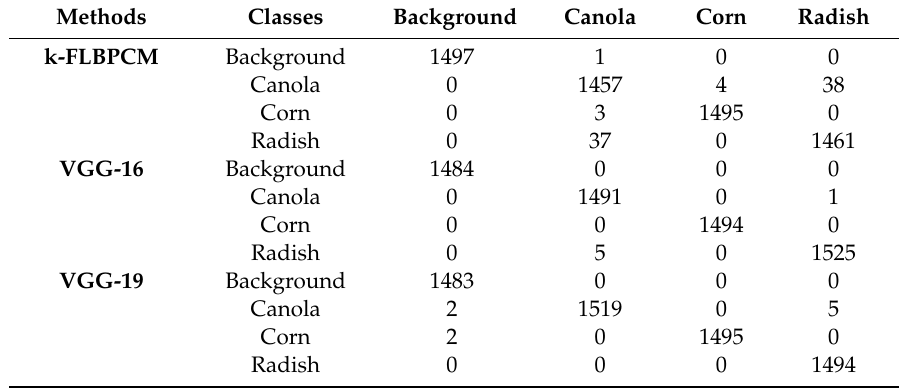
Table 3. Confusion matrices of the test set, in the “bccr-segset” dataset, for di ff erent methods, for a batch size of 32 and dropout